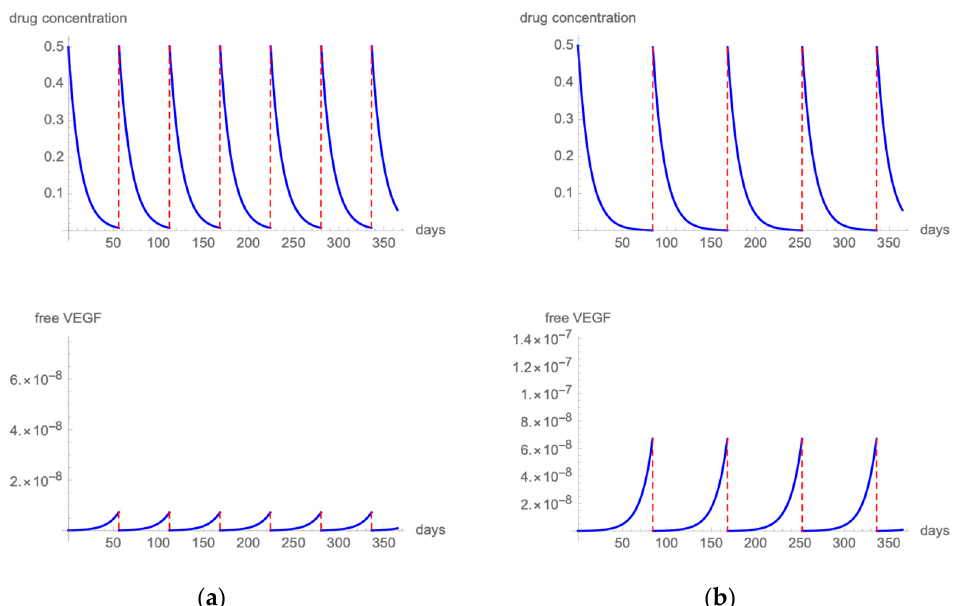
Figure 4. Figure 4 illustrates the intravitreal drug concentration and free VEGF proportion in a pa- tient treated with q8 ( a ) or q12 ( b ) 2 mg aflibercept injections. treated with q8 ( a ) or q12 ( b ) 2 mg aflibercept Brolucizumab